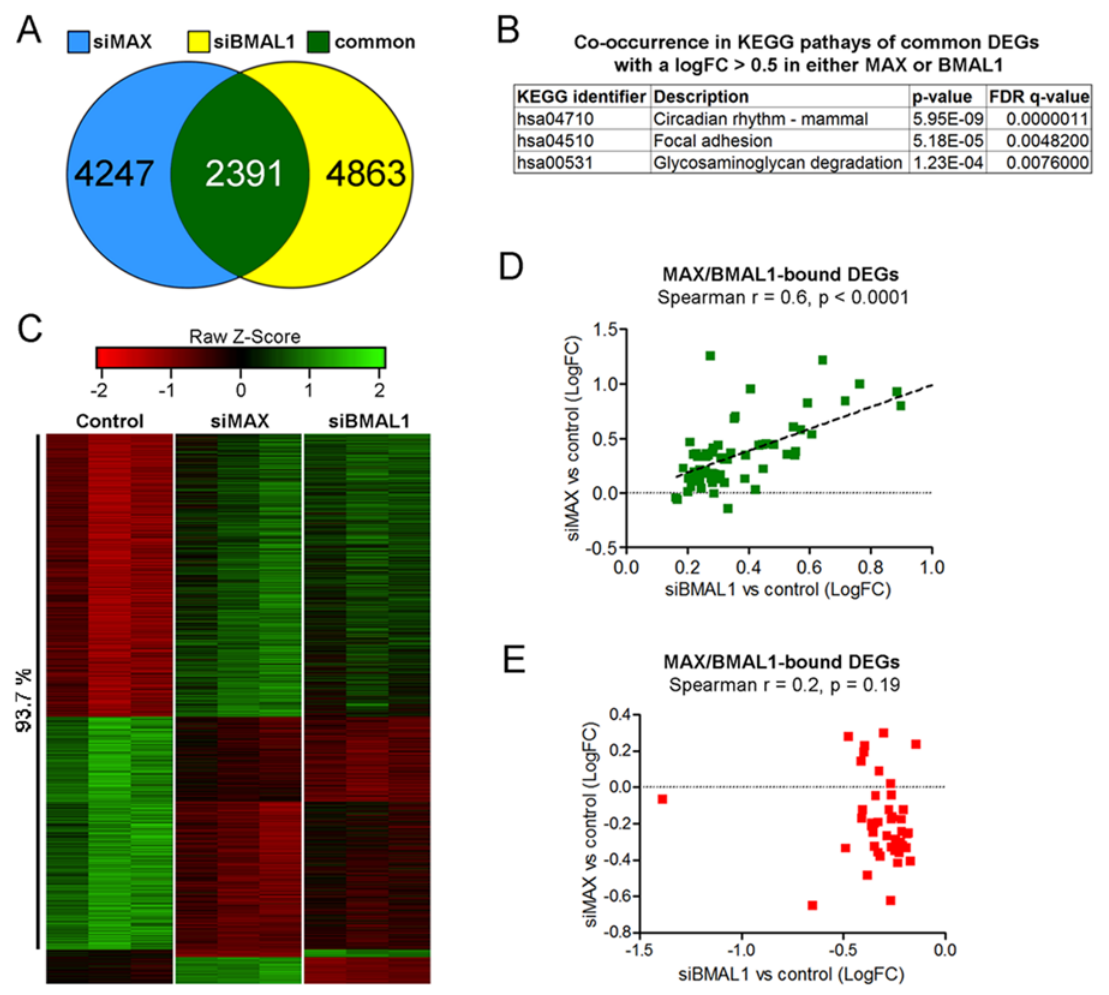
Figure 5. MAX and BMAL1 regulates the expression of common transcripts. ( A ) Venn diagram for differentially expressed genes (DEGs) in MDA-MB-231 cells with knocked down MAX (siMAX) or BMAL1 (siBMAL1). ( B ) Co-occurrence in KEGG pathways of the set of common siMAX and siBMAL1 DEGs with an absolute logFC > 0.5 upon the knockdown of either MAX or BMAL1 . ( C ) Clustered heat map of triplicate normalized counts from common siMAX:siBMAL1 DEGs. The percentage of genes coherently altered in both MAX - and BMAL -silenced cells compared with control is shown. ( D ) Significant correlation between MAX / BMAL1-bound genes up-regulated in BMAL1 -silenced and MAX -silenced cells. ( E ) Lack of correlation between MAX / BMAL1-bound genes downregulated in BMAL1 -silenced and MAX -silenced cells.